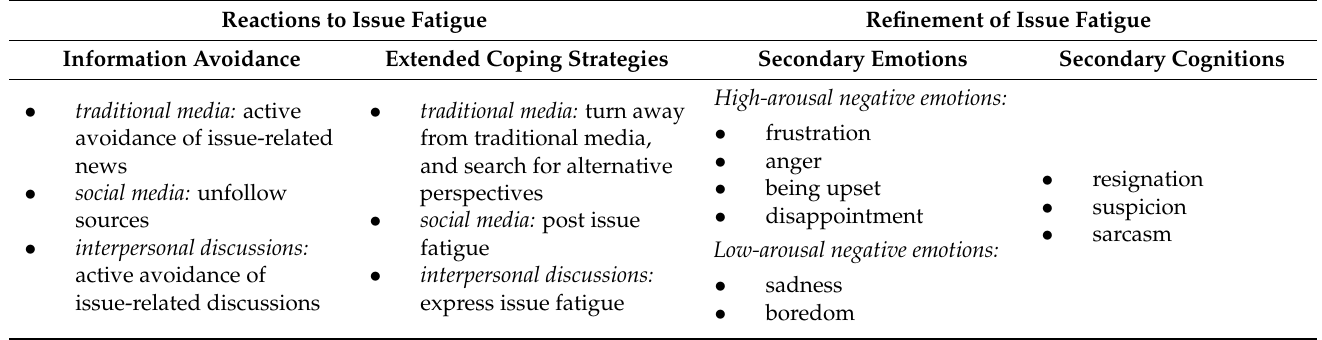
Table 1. Results from the qualitative exploration: reactions to issue fatigue, and secondary emotions and